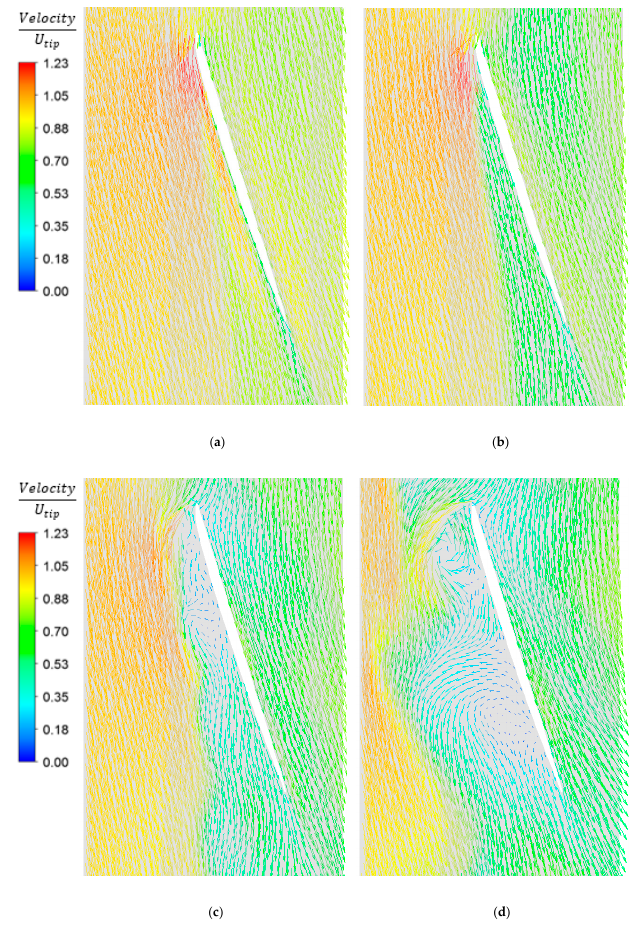
Figure 14. Non-dimensional velocity vector at the span SP0.98 for the impeller with varying discharge under a tip clearance of 0.1% span (( a ) ϕ = 0.4; ( b ) ϕ = 0.354; ( c ) ϕ = 0.329; and ( d ) ϕ =